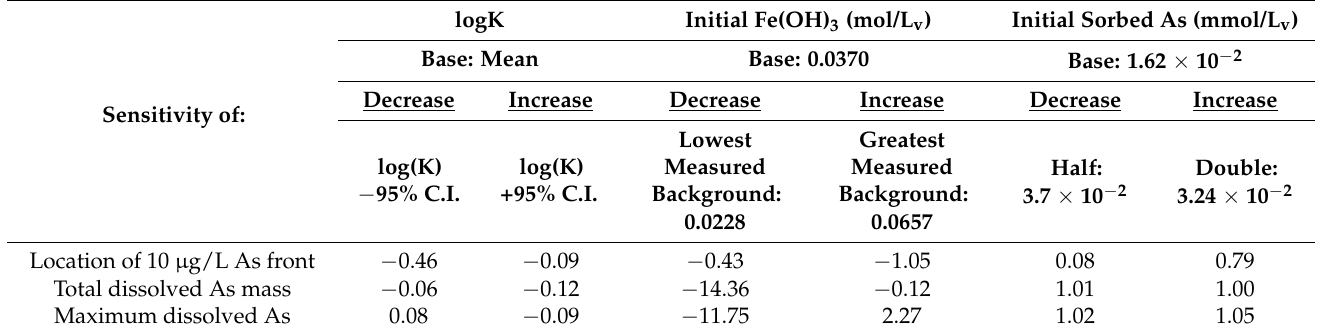
Table 3. Sensitivity coefficients for model independent variables (logK for surface complexation reactions, initial Fe(OH) 3 concentration, and initial sorbed As concentration) on the model dependent variables (location of the 10 µ g/L As front, the total dissolved As mass, and the maximum dissolved As concentration) 37 years after the spill. Sensitivity coefficients were calculated relative to the base case using Equation